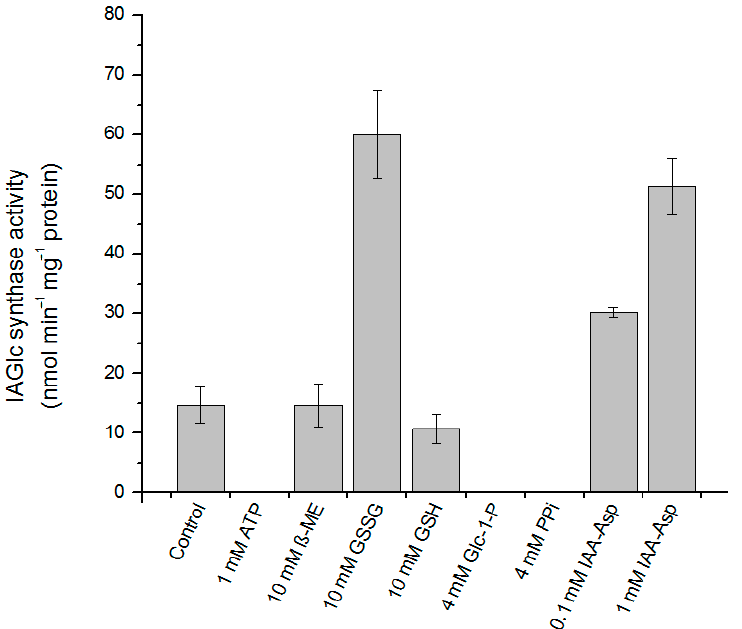
Figure 5. Effect of modulators on IAGlc synthase. Enzyme activity was determined using [ 14 C]IAA after TLC; the control mixture did not contain any modulators. Catalytic activity was expressed as the means ± SD for three repetitions. ATP—adenosine triphosphate; β -ME— β -mercaptoethanol; GSSG—oxidized glutathione; GSH—reduced glutathione; Glc-1-P—glucose-1-phosphate; PP i —pyrophosphate; IAA–Asp—indole-3-acetyl-aspartate.